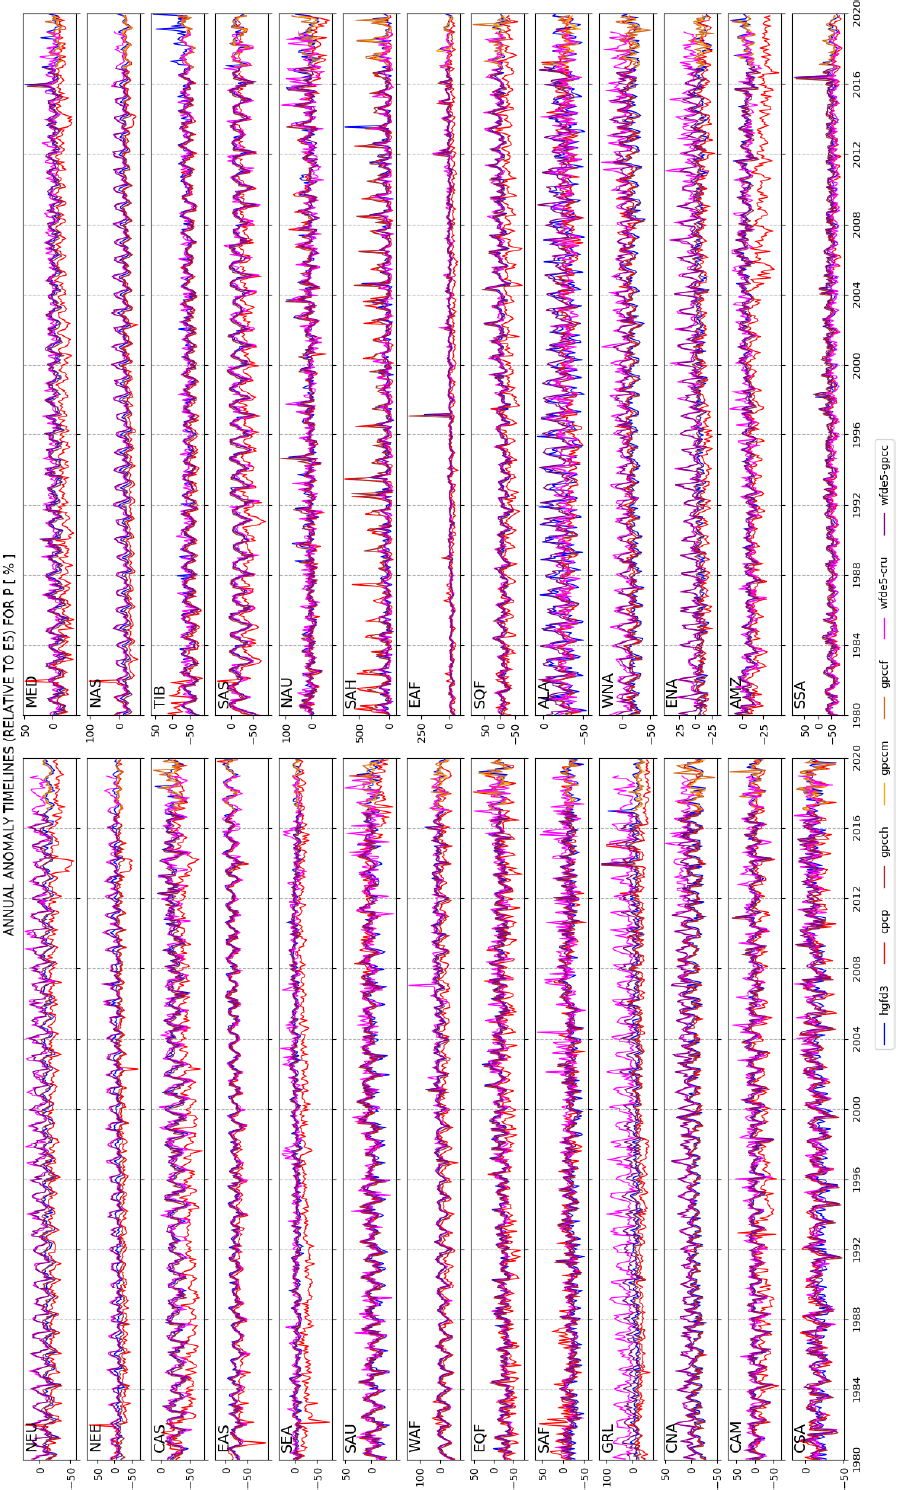
Figure 9. Monthly P anomalies for all data sets, averaged over the Giorgi regions for all valid land data points. The anomalies are relative to the e5 data set and are evaluated for each single